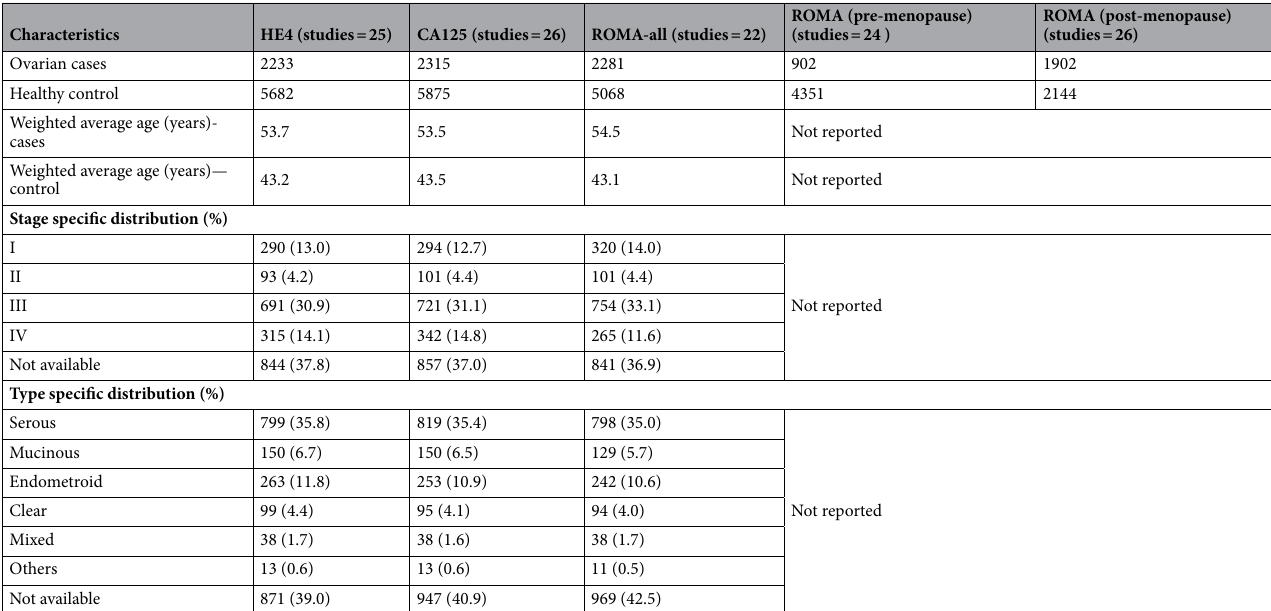
Table 1. Characteristic of patients undergone different diagnostic tests. Human epididymis secretory protein 4 (HE4), Cancer antigen (CA125) and Risk of Ovarian Malignancy Algorithm